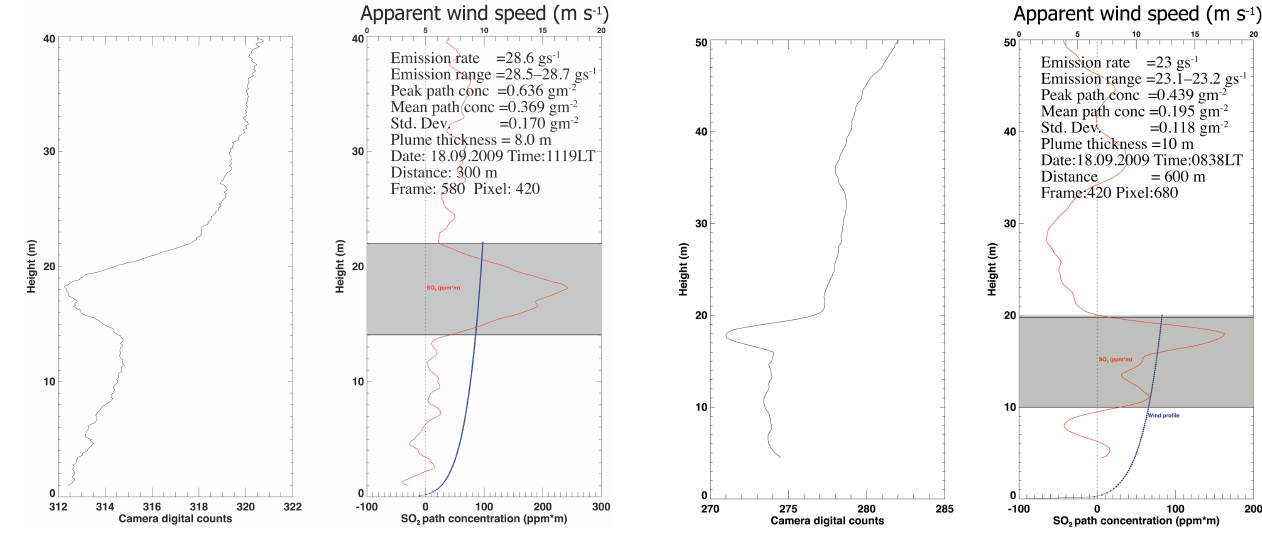
Fig. 15. SO 2 path concentration ( u , in ppmm) for the Stena Hol- landica